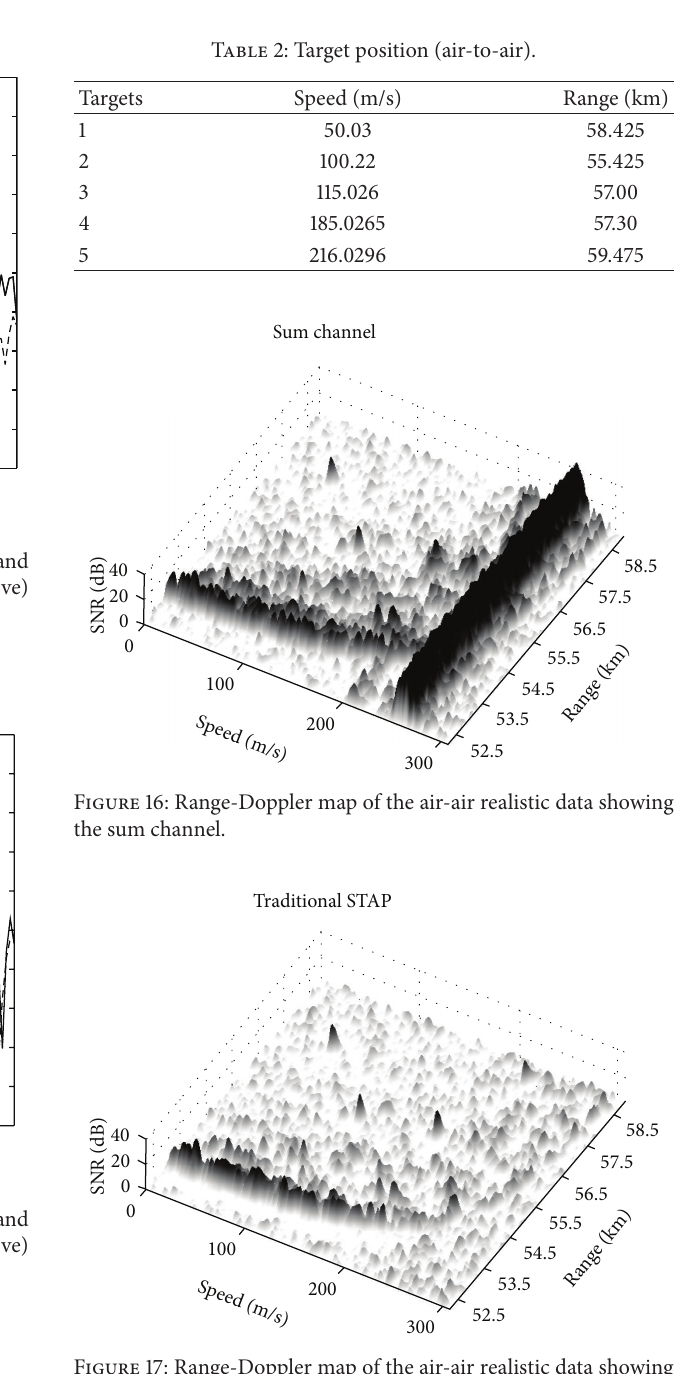
Figure 17: Range-Doppler map of the air-air realistic data showing the performance of MLED